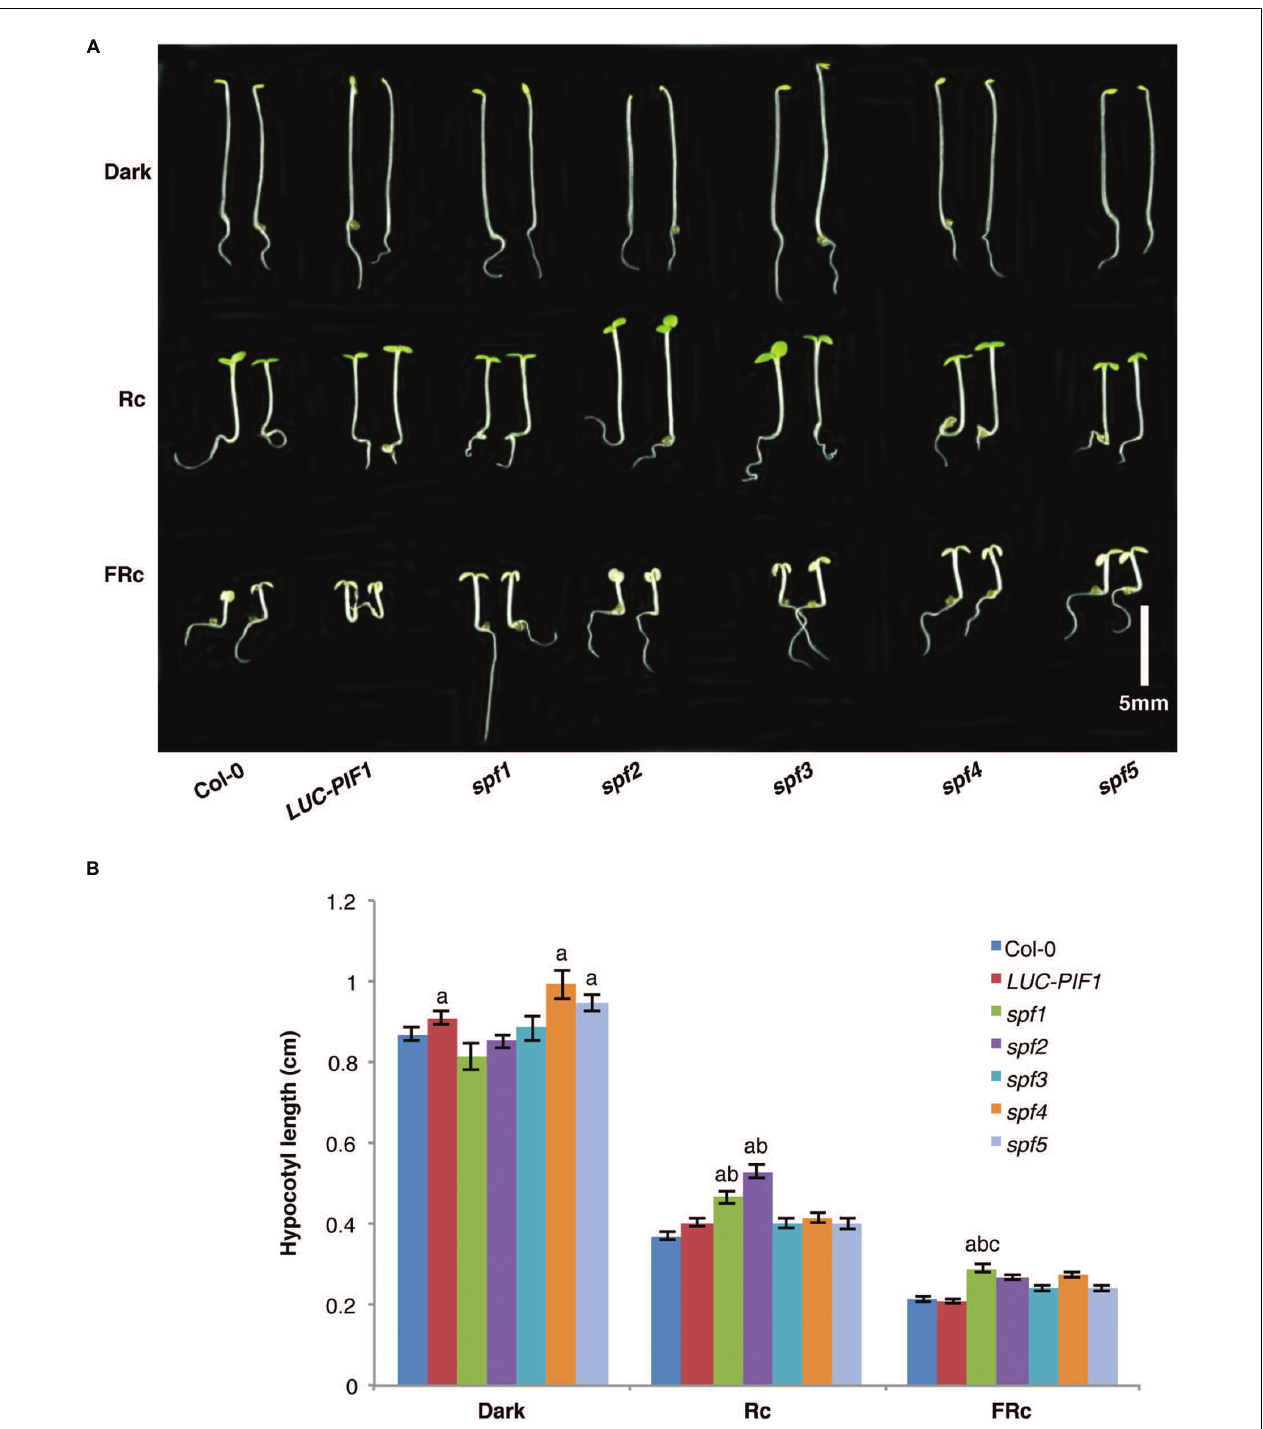
FIGURE 5 | The seedling de-etiolation phenotypes of the spf mutants and the control lines. (A) Seeds from each line were plated on MS media and stratified at 4 ◦ C in darkness for 4 days. Three hours of white light treatment was used to induce seed germination. The plates were then wrapped with aluminum foil and kept at 21 ◦ C for 21 h. Then they were grown under either 6 µ molm − 2 s − 1 red light, or 1 µ molm − 2 s − 1 far-red light, or kept in darkness for additional 3 days. Bar = 0.5 cm. (B) Bar graph shows the hypocotyl lengths of wild-type Col-0, LUC-PIF1 , spf1 , spf2 spf3 , spf4, and spf5 mutants grown under conditions described above. At least 40 seedlings were measured using ImageJ for each genotype under each condition. Error bars = SE. a, indicates statistically significant difference from rest of the samples in darkness; ab, indicates statistically significant difference from rest of the samples under Rc condition; and abc, indicates statistically significant difference from rest of the samples under FRc condition ( p ≤ 0.05).